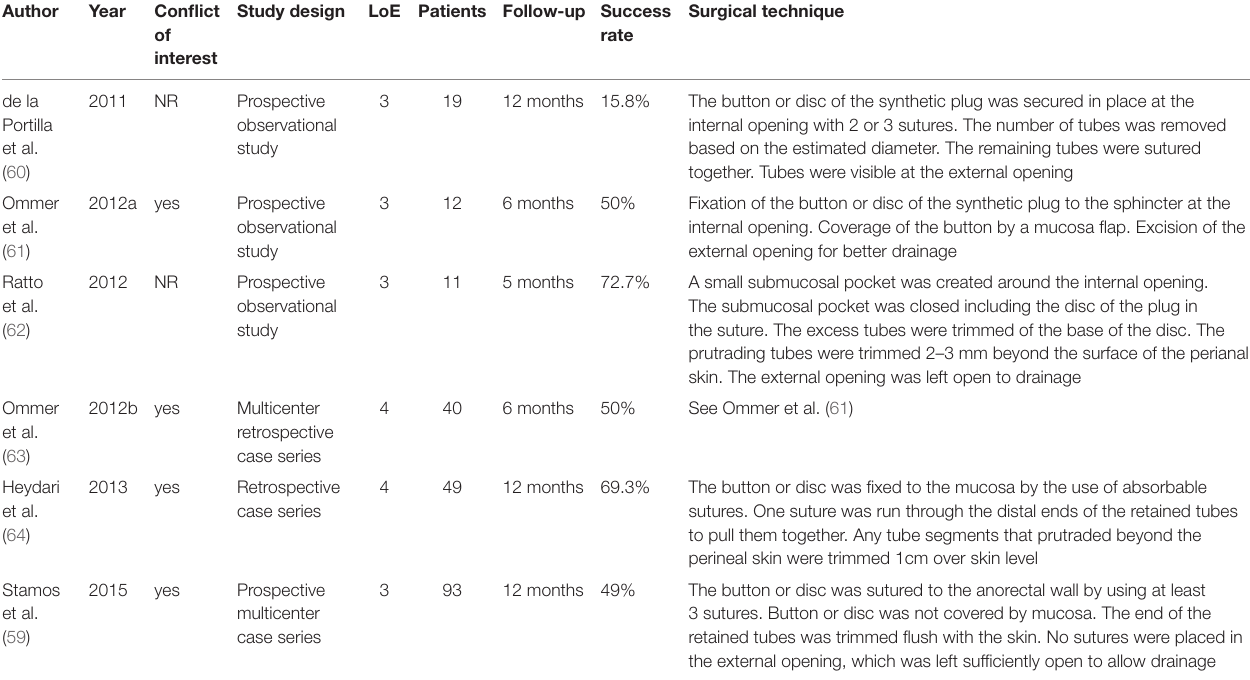
TABLe 6 | Case series of complex anal fistula repair with synthetic bioabsorbable anal fistula